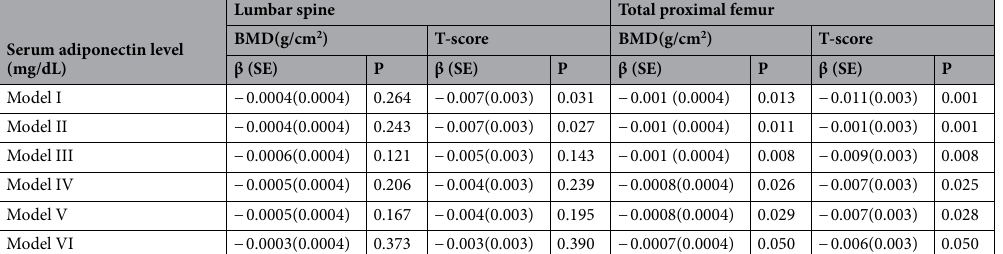
Table 3. The association between the changes of serum adiponectin levels and changes of lumbar spine/total proximal femur BMD and t-score using generalized estimating equation (GEE) models. Model I: adjusted for time and time 2 . Model II: adjusted for age, time and time 2 . Model III: adjusted for age, time, time 2 , isoflavone treatment, hospital sites, history of diabetes, hypertension and hyperlipidemia as well as average total METs spent and total calories consumed. Model IV: Model III plus body mass index. Model V: Model IV plus bone alkaline phosphatase. Model VI: Model IV plus urinary N-telopeptide of type 1